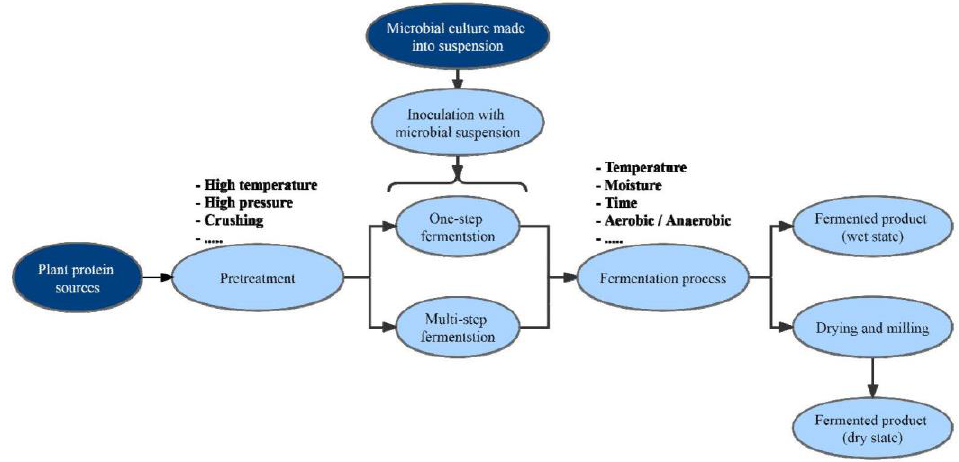
Figure 3. Schematic representation of steps involved in the solid-state fermentation of plant protein sources.